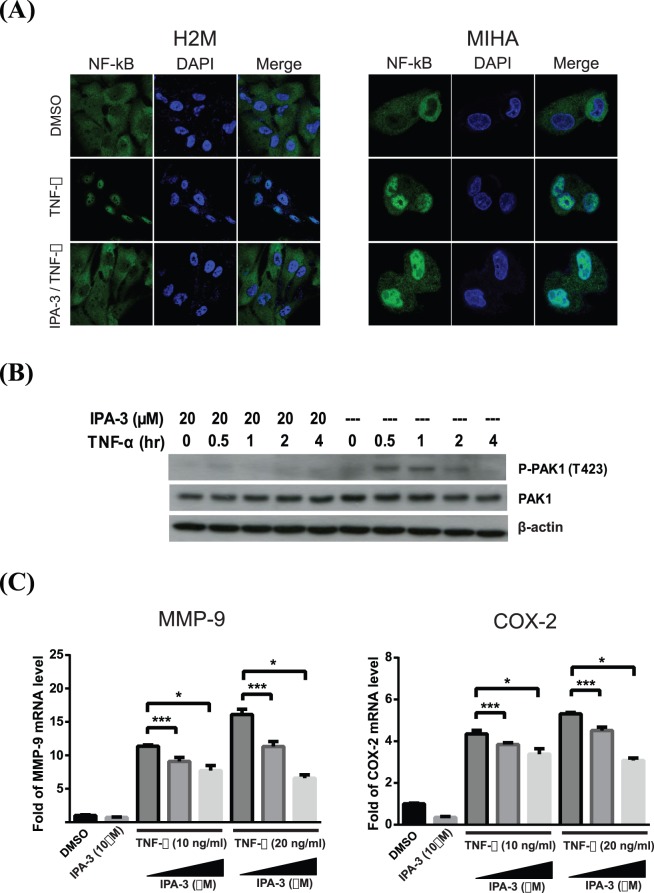
The inhibitory effect of IPA-3 on NF-κB nuclear translocation.(A) Effect of IPA-3 on subcellular localization of NF-κB was evaluated by immunofluorescence staining. After overnight serum starvation, H2M (left panel) and MIHA (right panel) cells were treated with either DMSO or IPA-3 (20 µM, 15 minutes) followed by an addition of TNF-α (20 ng/ml, 15 minutes). NF-κB was detected with a specific antibody (Green) and nucleus was stained with DAPI (Blue). (B) Western blotting analysis of P-PAK1 (T423) and total PAK1 were detected in the H2M cells stimulated by TNF-α (20 ng/ml) with or without IPA-3 pretreatment (20 µM, 15 minutes). TNF-α was included in the culture medium for 0, 0.5, 1, 2 or 4 hours. (C) Expression of quantitative real-time PCR was performed to analyze the mRNA level of MMP-9 (left panel) and COX-2 (right panel). Serum-starved H2M cells were treated with or without IPA-3 pretreatment (10 or 20 µM, 15 minutes) followed by TNF-α (10 or 20 ng/ml, 24 hours). Quantitative results of MMP-9 and COX-2 mRNA levels were normalized to β-actin. The values represented the mean ± SD of three independent experiments. *P<0.001 (ANOVA), ***P<0.05 (ANOVA) compared with the TNF-α control.